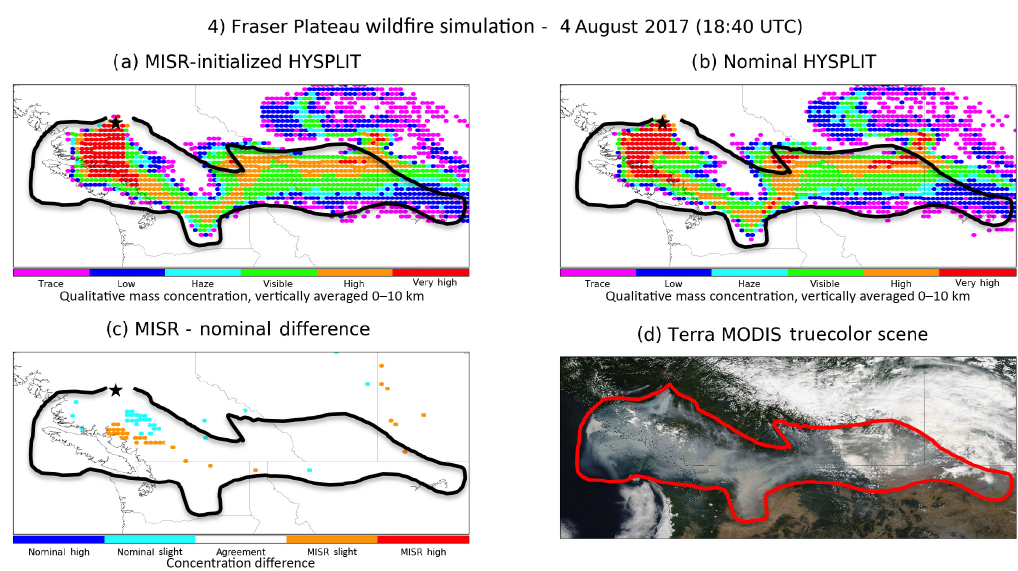
Figure 4. Same as Fig. 2, but for the Fraser Plateau Fire plume on 4 August 2017. (a–b) Day 2 samplings of HYSPLIT 96h simulations that began on 3 August 2017, and (c) Day 2 difference plot. (d) MODIS true-color image acquired on 4 August